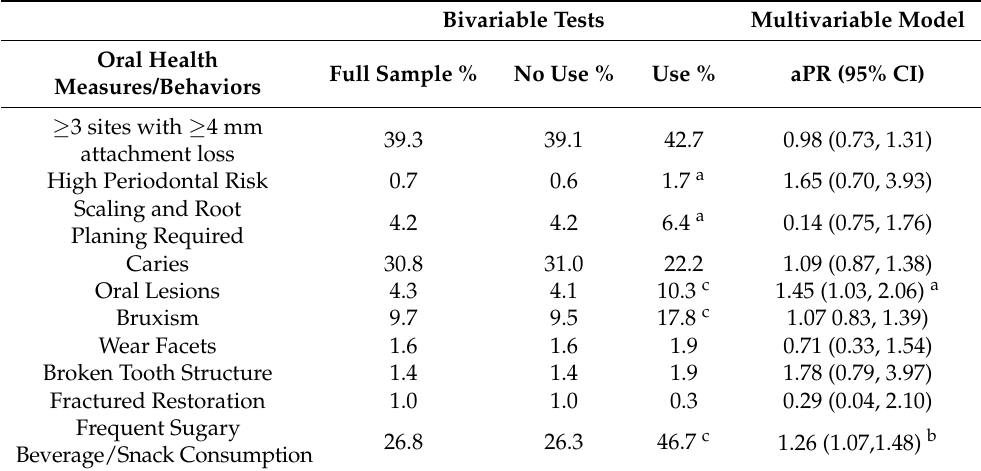
Table 3. Associations between self-reported current cannabis use and oral health